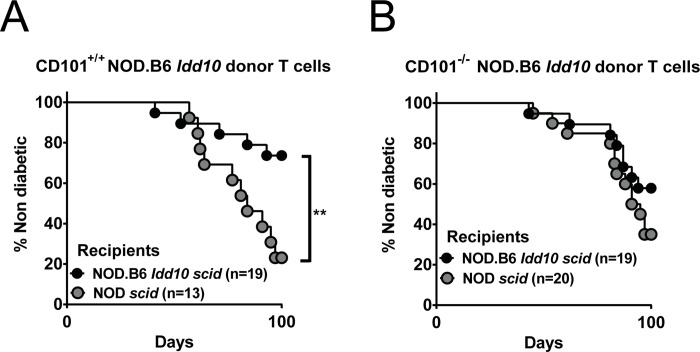
B6-derived Idd10 region in myeloid cells as well as T cells provides the greatest degree of protection from T1D.The frequency of T1D was assessed by the analysis of urinary glucose concentration in NOD Idd10 scid and NOD.B6 scid recipients upon transfer of 5x107 T cells from 6-8-week-old CD101+/+ NOD.B6 Idd10 (A) or CD101−/− NOD.B6 Idd10 mice (B). The indicated numbers of female recipients in each cohort were analyzed until day 100 after the adoptive T cell transfer. Kaplan–Meier survival curves were plotted for each mouse strain, and statistical significance was determined by log rank test (*, p<0.05).